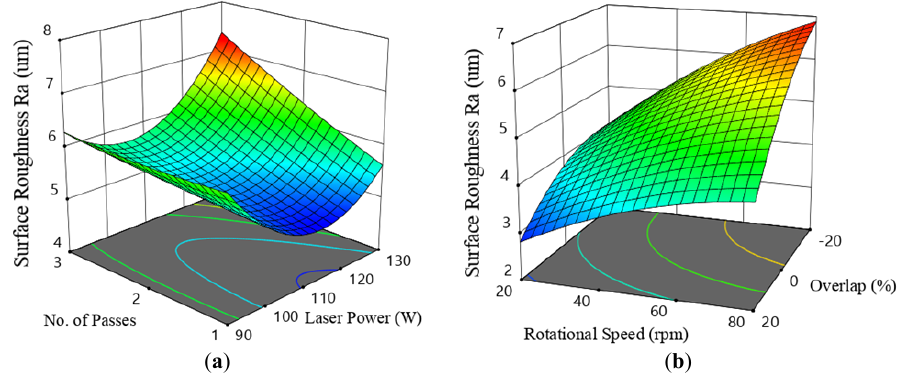
the sample surface. positioned on